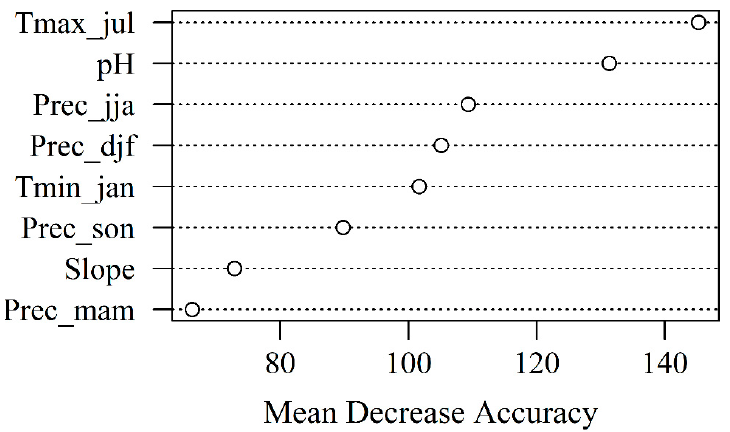
Figure 1. Relative importance of climatic variables, expressed as mean decrease accuracy, in the classification process as derived from random forest calibration. Variables are pH; slope; Tmax_jul: monthly average maximum temperature of July; Tmin_jan: monthly average minimum temperature of January; Prec_djf, Prec_mam, Prec_jja, and Prec_son cumulated precipitation of winter, spring, summer and autumn seasons, respectively.